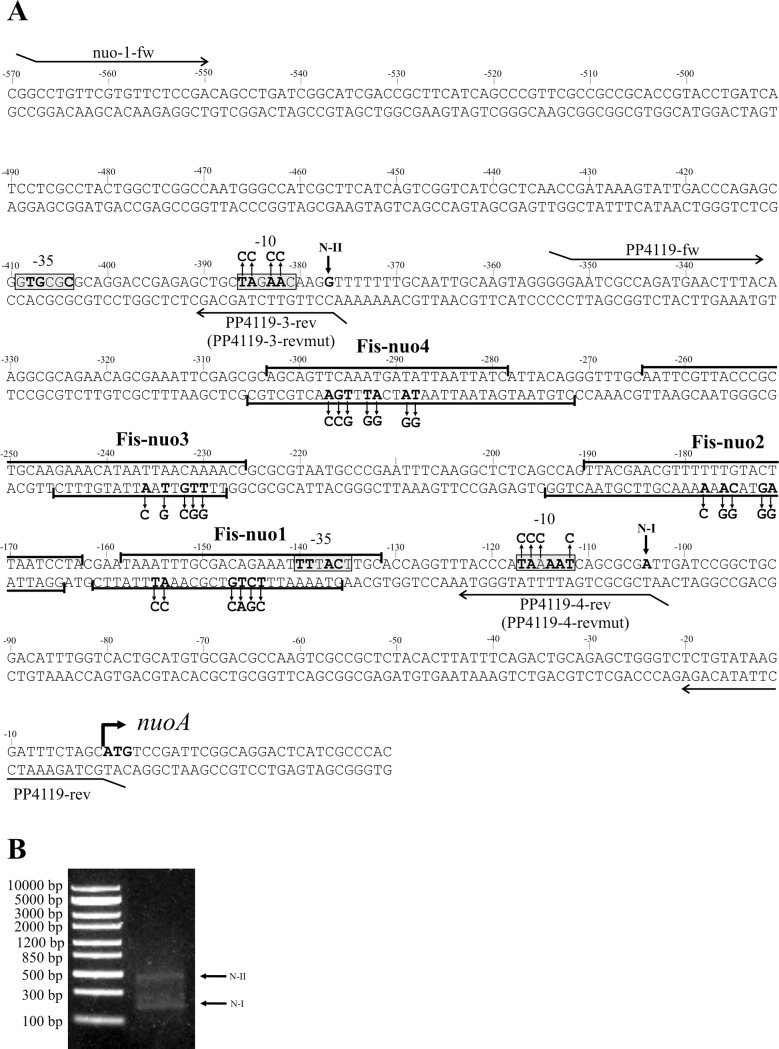
Mapped Fis binding sites, putative promoters, and 5´ends of mRNA at the nuoA promoter region.(A) The sequence of the nuoA promoter region. The ATG start codon of the nuoA gene is shown in bold. The first nucleotides of the mRNA 5´ ends are written in bold and designated as N-I and N-II. The potential –10 and –35 elements of the nuoA promoters (PN-I and PN-II, respectively) are shown in grey boxes. The nucleotides in -10 and -35 box corresponding to P. putida σ70-type promoter consensus (TTGACC-N17-TATAC/aT) are indicated in bold. The Fis binding sites are shown in black brackets. The point mutations in the Fis-nuo1, Fis-nuo2, Fis-nuo3, Fis-nuo4 and -10 boxes of promoters are indicated by arrows. The oligonucleotides PP4119-fw and PP4119-4-rev were used for the construction of p9_PnuoA1, nuo-1-fw and PP4119-3-rev were used for the construction of p9_PnuoA2, and nuo-1-fw and PP4119-rev were used for the construction of p9_PnuoA12. (B) Agarose-gel electrophoresis of cDNA amplified by the RACE method for the identification of the nuoA mRNA 5´ ends. The arrows point to the PCR products used to determine the mRNA 5´ ends.